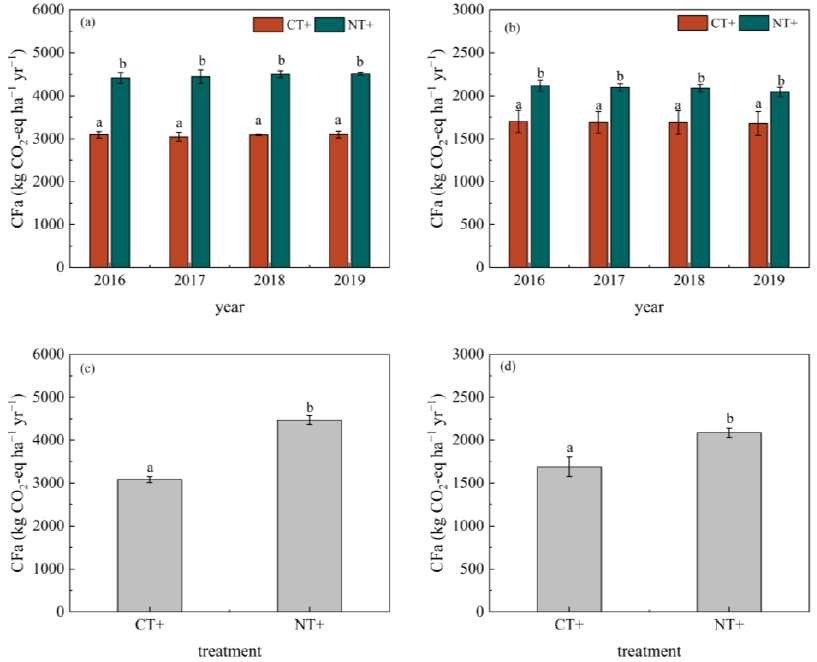
Figure 5. CFa of wheat production from 2016 to 2019 at ( a ) Wudi and ( b ) Yucheng; four-year average CFa at ( c ) Wudi and ( d ) Yucheng sites. CT+ is crop residue incorporated into the soil with plough tillage, NT+ is crop residue mulching soil with no-till. The small letters indicate the significant differences across treatments at p < 0.05 level.